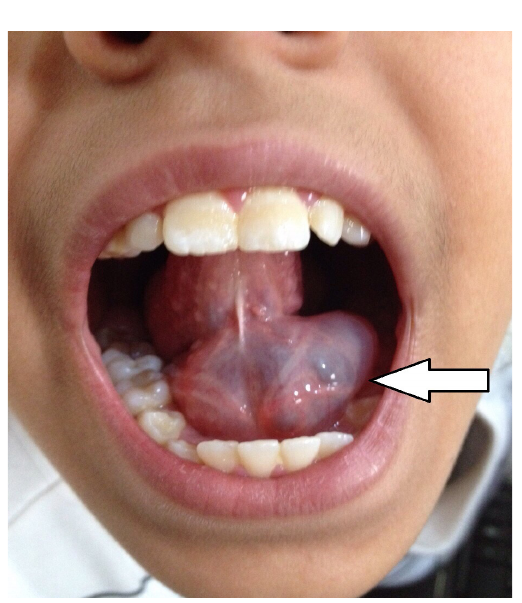
Figure 1. The sublingual mass, a simple ranula, seen on physical exam of a pediatric